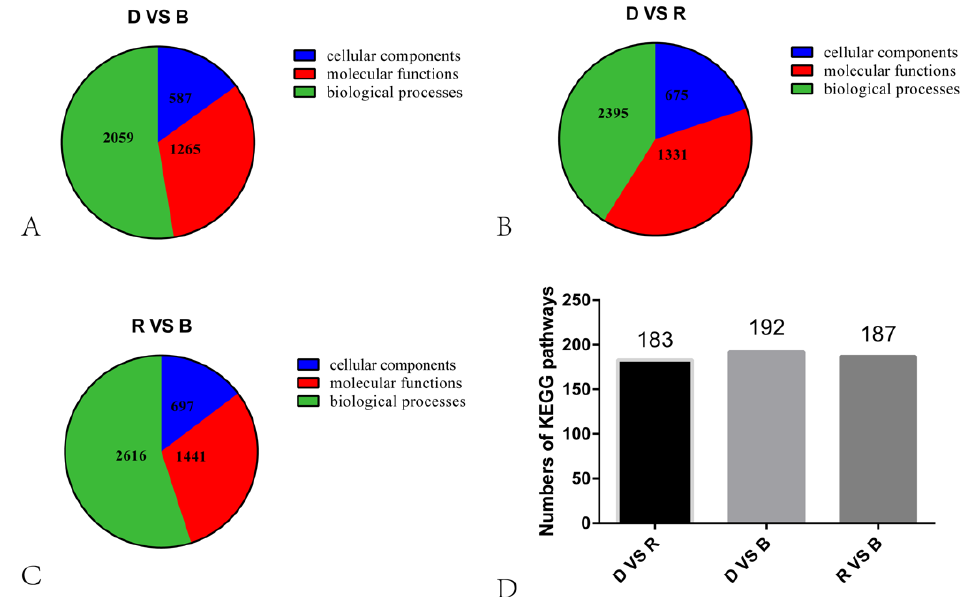
Figure 4. Statistical results of KEGG and GO analyses. ( A – C ). Pie chart showing the numbers of GO terms across the three categories. ( D ). The bars indicate the numbers of KEGG pathways. In the D vs. B comparison, the 4561 DEGs were enriched in 3911 terms, including 587 terms in the cellular component category, 1265 terms in the molecular function category and 2059 terms in the biological process category. In the D vs. R comparison, 5355 DEGs were enriched in 4401 terms, including 675 terms in the cellular component category, 1331 terms in the molecular function category and 2395 terms in the biological process category. These results are displayed in Supplementary Tables S1 and S2. There were 16 GO terms related to light, which are presented in Figure 5 and Supplementary Tables S1 and S2. Among these GO terms, deoxyribodipyrimidine photolyase activity (GO: 0003904), re- sponse to light stimulus (GO: 0009416), and photoreceptor connecting cilium (GO: 0032391) were significantly enriched in both the D vs. B and D vs. R comparisons, imply- ing that light has a great influence on primordium differentiation and that this influence may be exerted through deoxyribodipyrimidine photolyase. The KEGG pathway enrich- ment results for the D vs. B comparison and the D vs. R comparison are provided in Sup- plementary Tables S3 and S4, respectively. We focused on the top 20 pathways (Figure 6) and found that the DEGs in these two comparisons were highly concentrated in the KEGG pathways MAPK signaling pathway (MSPY; ko04011), oxidative phosphorylation (OP; ko00190), and RNA transport (RT; ko03013), implying that signal transduction, material and energy metabolism remained significantly active during primordium differentiation in P. eryngii ; this finding deserves special attention.